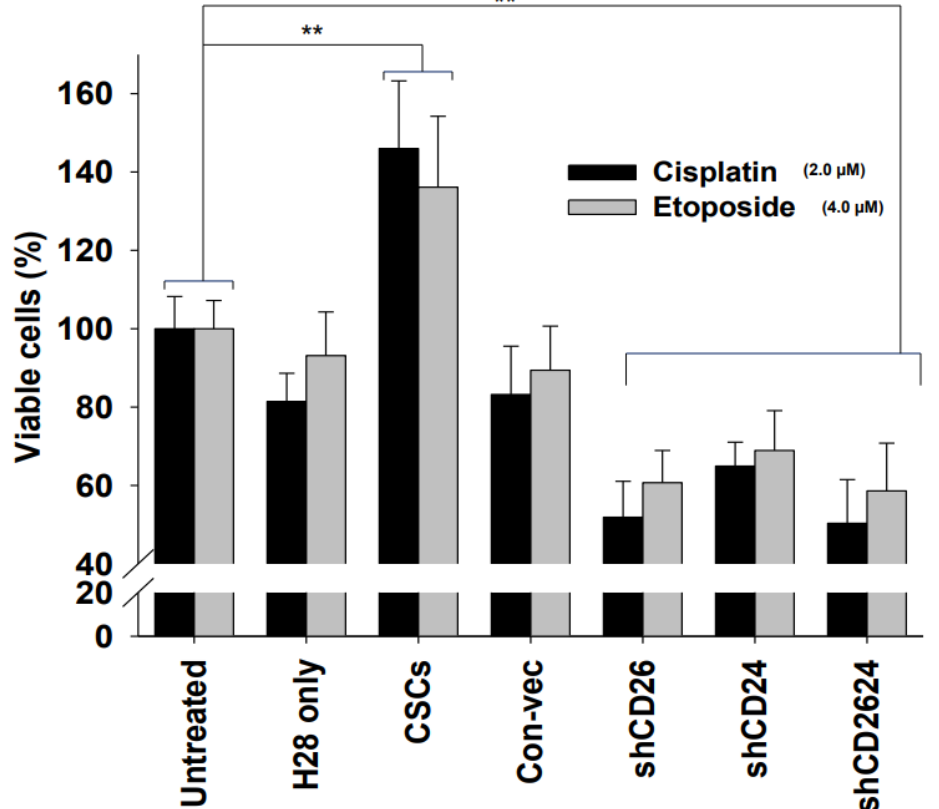
Figure 2. Effects of anti-cancer drugs (cisplatin and etoposide) on cells. MMs were incubated for 24 h and two chemotherapeutic drugs, cisplatin and etoposide, were employed to test drug sensitivity for 1 h. The media were replaced with fresh media. After 72 h, cell viability was measured by CellTiter96 kit. Mean ± SD ( n = 3), p < 0.01 (**).